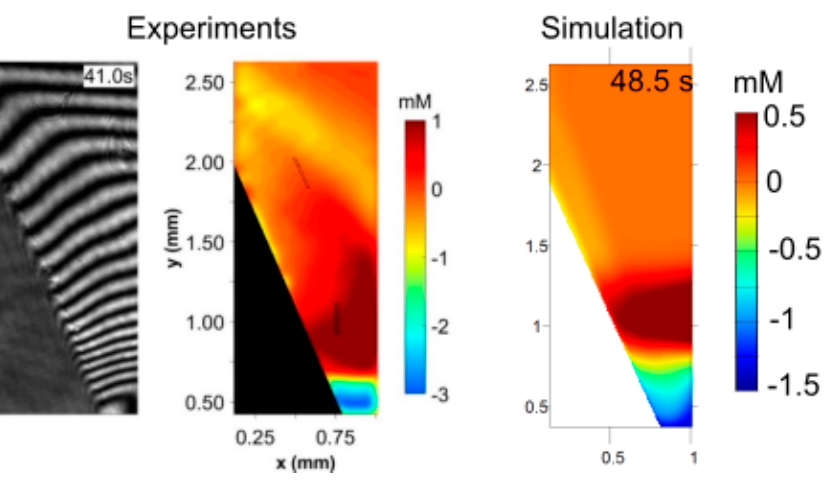
Figure 13. Comparison between experimental and numerical results for variation in the concentra- tion at 41 s for experiments and 48.5 s for simulations for the case 4 mA/cm 2 , when the concentra- tion at the lower monitoring point reaches a maximum. Both results are averaged in the laser di-